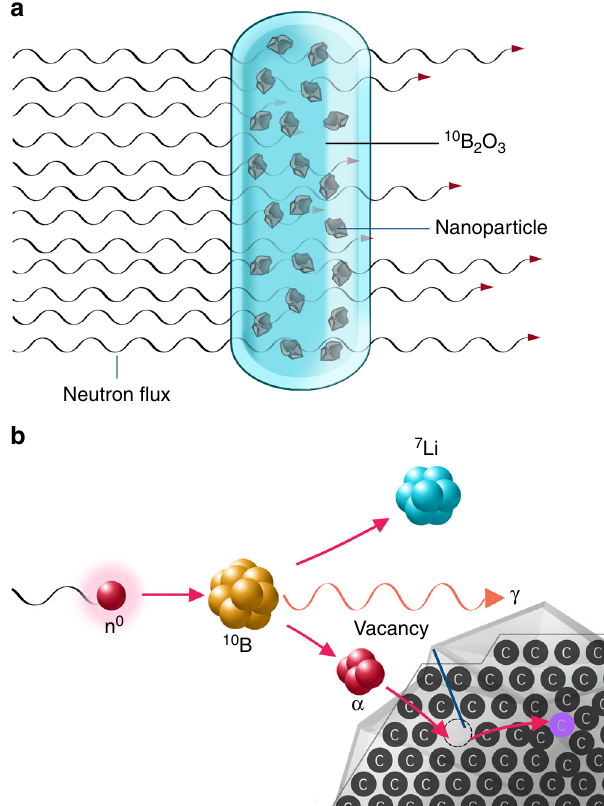
Fig. 1 Basic principle of the implantation of energetic ions generated in situ into nanoparticles. a A container containing nanoparticles embedded in a glassy melt of 10 B 2 O 3 exposed to a neutron fl ux. b Detail of α particles and 7 Li + ions formed in situ by 10 B neutron capture entering a nanodiamond particle and creating vacancies